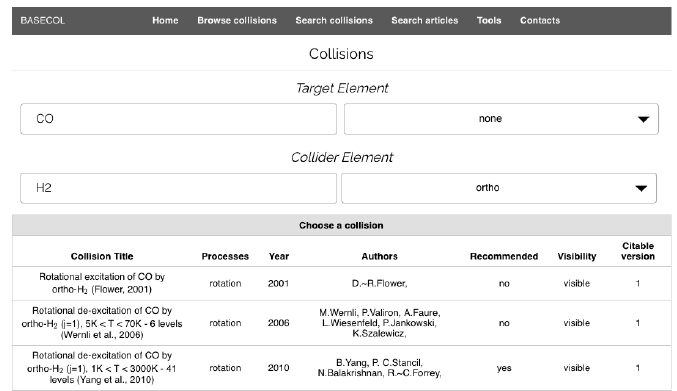
Figure 4. Query Interface with “Browse Collision” for collisional rate coefficients of CO–ortho-H 2 .